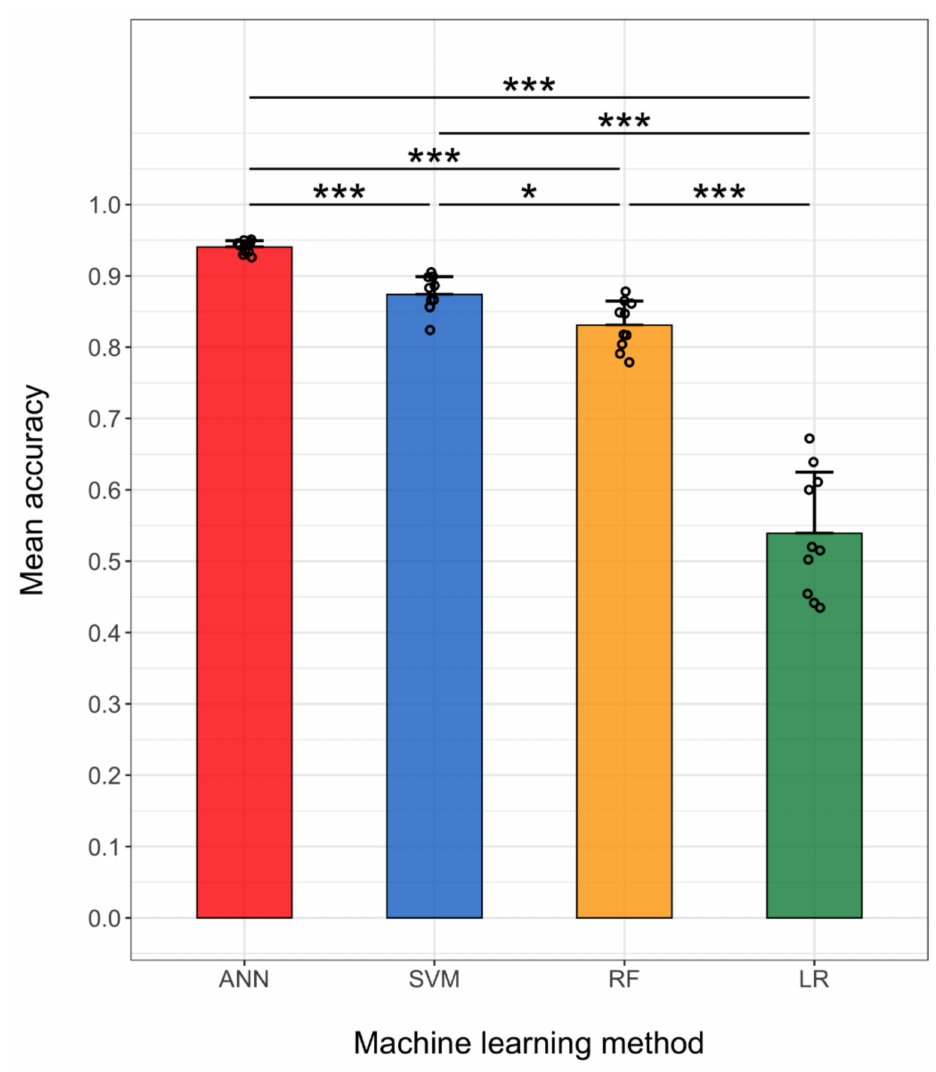
Figure 8. Mean and standard deviation (error bars) of accuracy values obtained with the ANN, SVM, RF, and LR, and plot of the accuracy obtained with each subject (black circles). The machine learning methods significantly affected the accuracy ( p < 0.001, one-way ANOVA). Post-hoc comparisons between machine learning methods were conducted using the Games–Howell method ( * p < 0.05, *** p < 0.001). The variances in accuracy of the different machine learning methods were determined using F-tests with the FDR